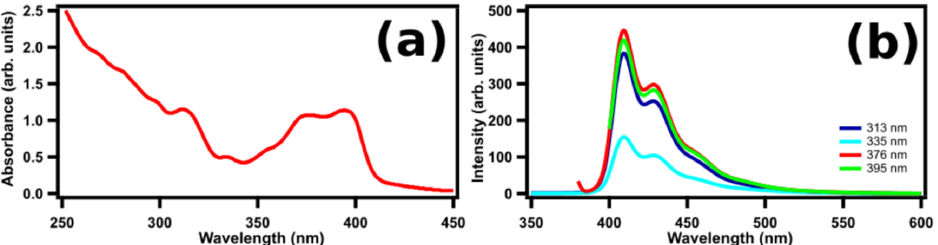
Figure 4. ( a ) UV-Vis absorption and ( b ) PL spectra of (M)-[7]TH-diol molecules in CHCl 3 with concentration of 1.0 × 10 − 5 M. Both UV–Vis absorption and PL spectra indicate the Franck-Condon vibronic progression. (M)-[7]TH-diol molecules adsorbed on the Au(111) surface (curve #2), C 60 island grown on Au(111) (curve #3), and (M)-[7]TH-diol molecules adsorbed on C 60 island grown on Au(111) surface (curve #4). All spectra were obtained under the same conditions: at sam- ple bias of − 3.0 V and tunneling current of 500 pA with an acquisition time of 5 min during the STM raster scan on the area of 50 × 50 nm 2 . All spectra are raw ones with the appro- priate amplification of the intensities for supporting the comparison among each other.